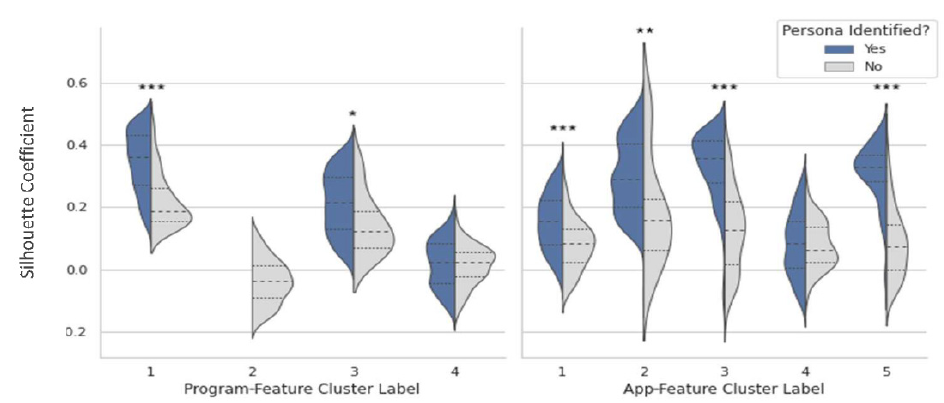
Figure 3. Violin plots of silhouette coefficient distributions with median (interquartile range) for the four program-feature clusters ( left ) and five app-feature clusters ( right ). The median silhouette coefficients (longer, dashed lines) for members with an identified engagement persona were higher than the medians for members without an identified engagement persona for all but program-feature cluster 4 and app-feature cluster 4. Mann–Whitney U tests between members with vs. without an identified engagement persona, * p ≤ 0.05; ** p ≤ 0.001; *** p ≤ 0.0001.